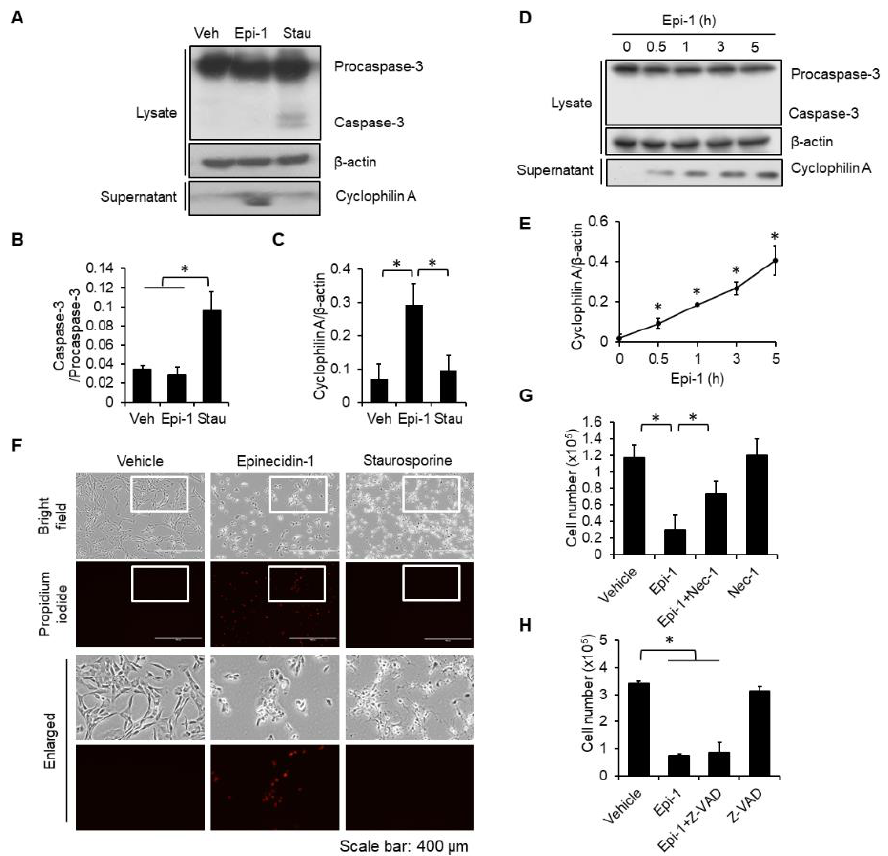
Figure 2. Epi-1 triggers caspase-independent cell death. ( A and C ) Cells were treated with epi-1 (6.125 μM) or stau (1 μM) for 3 h. Supernatants were collected and immunoblotted for cyclophilin A. Cell lysates were collected and immunoblotted for caspase-3 and β-actin. ( A and B ) Band intensities were quantified by ImageJ. ( D ) Cells were treated with epi-1 for different times, and cell lysates and supernatants were collected and immunoblotted with indicated antibodies. ( E ) Band intensities were quantified. ( F ) Cells were treated with epi-1 or stau as described in ( A ). After stimulation, cells were loaded with propidium iodide (PI; 1 μg/mL) for 10 min. After rinsing cells with PBS, PI incorporation was observed by fluorescence microscopy. Cells were pretreated with Necrostatin-1 (Nec-1) (10 μM) ( G ) or Z-VAD-FMK (Z-VAD) (100 μM) ( H ) for 1 h, followed by epi-1 (6.125 μM) treatment for 24 h. Cytotoxicity was determined by the trypan blue exclusion assay. * p < 0.05 was considered significant. 2.3. Calcium and Calpain are Required for Epi-1-Induced Cell Death Necrosis often involves intracellular calcium overload, which subsequently activates cell death- inducing molecules, such as calpain [18]. Epi-1 treatment elevated the intracellular calcium level within 15 min, and the elevation was sustained to 60 min (Figure 3A,B). Calcium chelator BAPTA blocked cell death, suggesting that calcium is necessary for epi-1-mediated cytotoxicity (Figure 3C). Calpain activity was also quickly induced within 15 min (Figure 3D), and suppression of calpain activity by PD151746 inhibited epi-1-mediated cytotoxicity (Figure 3E). Since BAPTA attenuated epi- 1-mediated upregulation of calpain activity (Figure 3F), calcium seems to be required for epi-1- mediated activation of calpain.